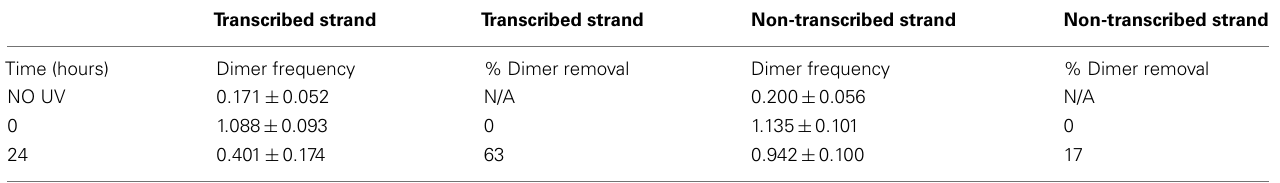
Table 1 | Preferential repair of CPDs in transcribed strand of the Arabidopsis thaliana RPII gene. Transcribed strand Transcribed